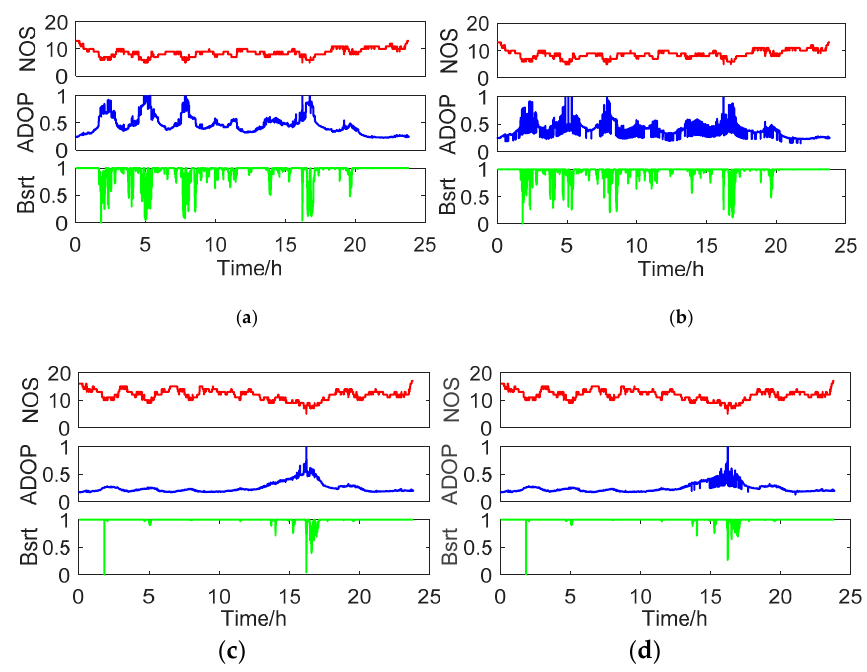
Figure 6. Mean NOS, ADOP, and bootstrapped success rates of different strategies for baseline shm1-shm4: ( a ) GPS, ( b ) C-GPS, ( c ) GPS / Galileo, and ( d ) C-GPS / Galileo. Table 3. NOS, PDOP, ADOP, success rate and position deviation of different strategies for baseline shm1-shm4.